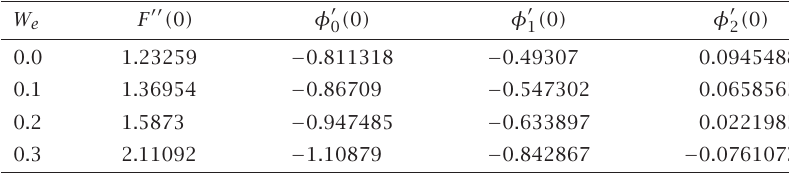
Table 3.1 . Numerical values of F (cid:6)(cid:6) ( 0 ) , φ (cid:6) different values of W e